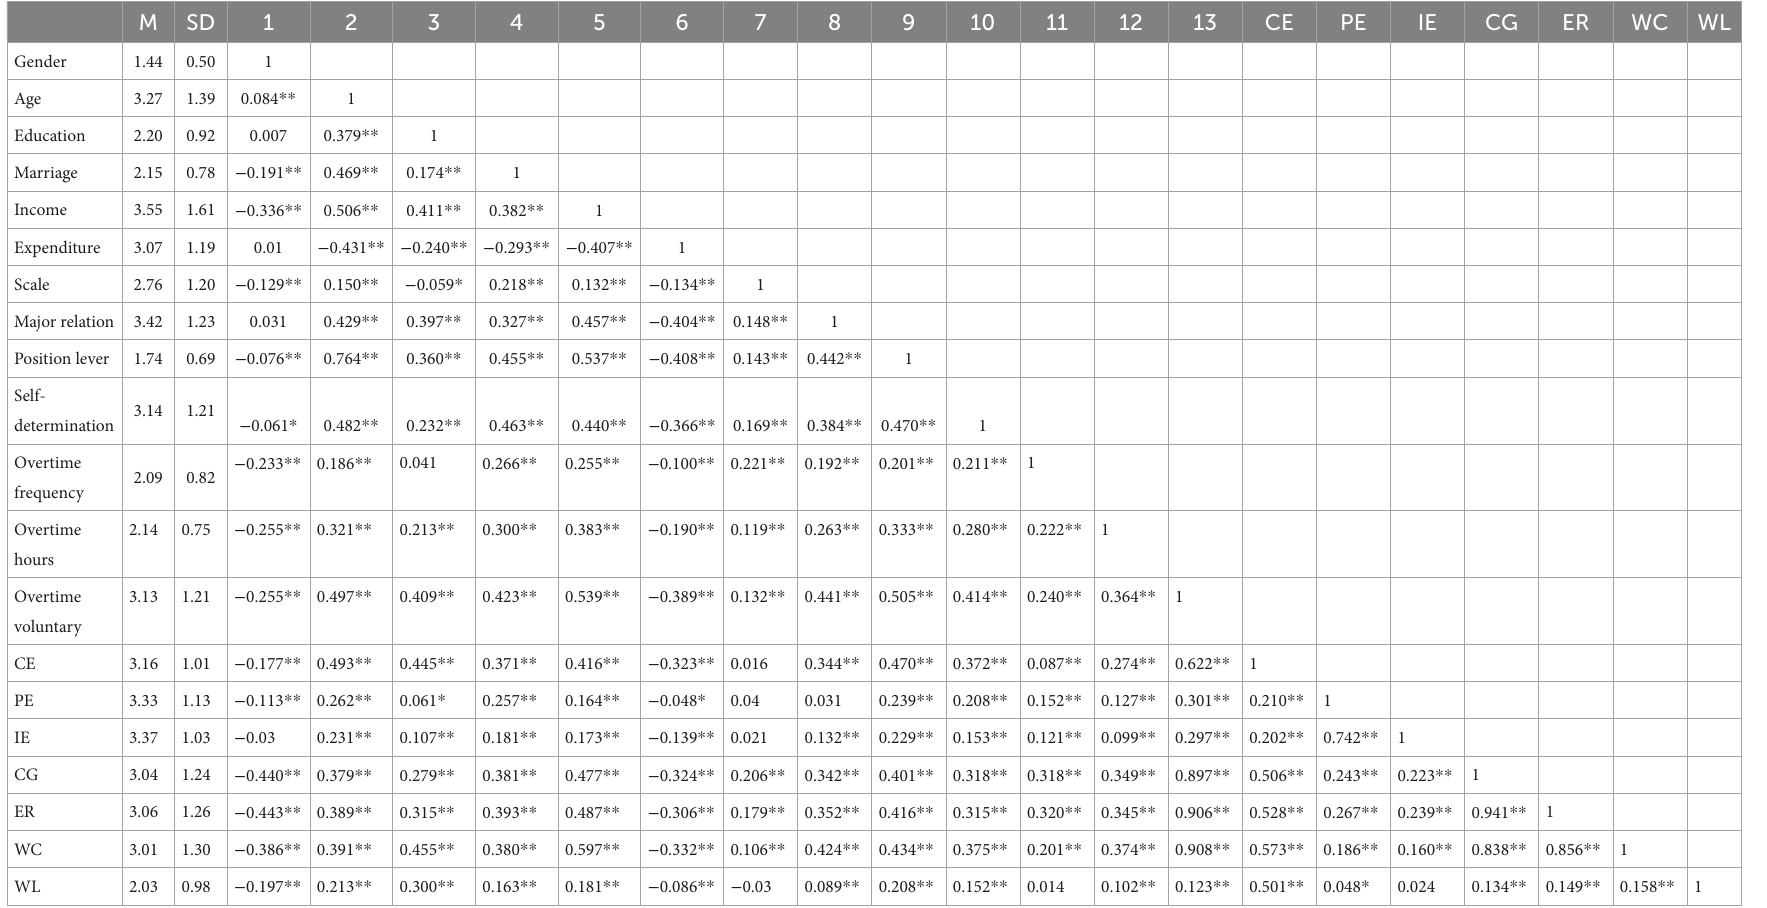
* Indicates significant correlation at the 0.05 level (two-tailed); ** Indicates significant correlation at the 0.01 level